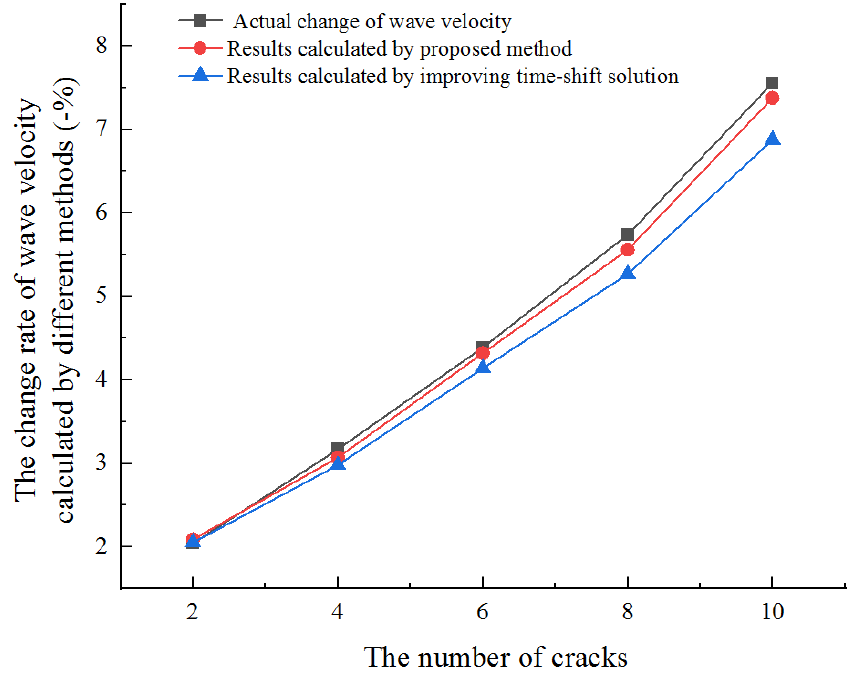
Figure 11. Results calculated by the proposed method in this paper and the method which only improves the time-shift solution.